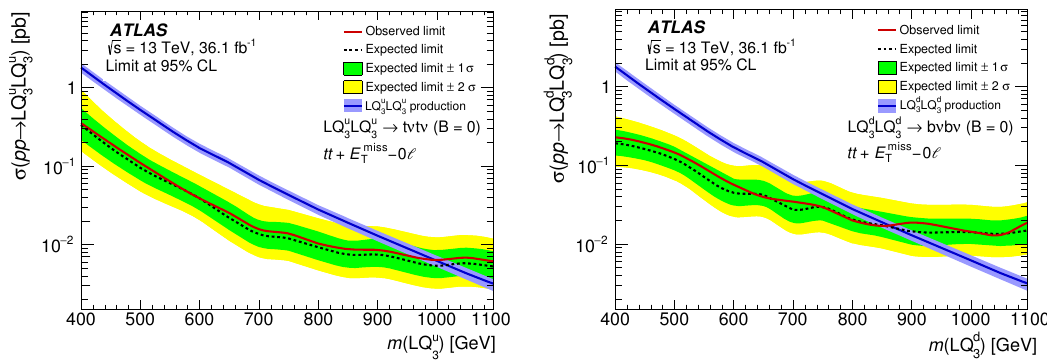
Figure 12 . Observed and expected 95% CL upper limits on the cross-section for up-type (left panel) and down-type (right panel) LQ pair production with B = 0 as a function of the LQ mass. The (cid:6) 1(2) (cid:27) uncertainty bands around the expected limit represent all sources of statistical and systematic uncertainties. In the right panel the expected limit has an undulated behaviour due to the use of di(cid:11)erent signal regions for di(cid:11)erent mass points and the statistical uncertainties of the background MC in SRD. The thickness of the theory curve represents the theoretical uncertainty from PDFs, renormalization and factorization scales, and the strong coupling constant (cid:11) s .